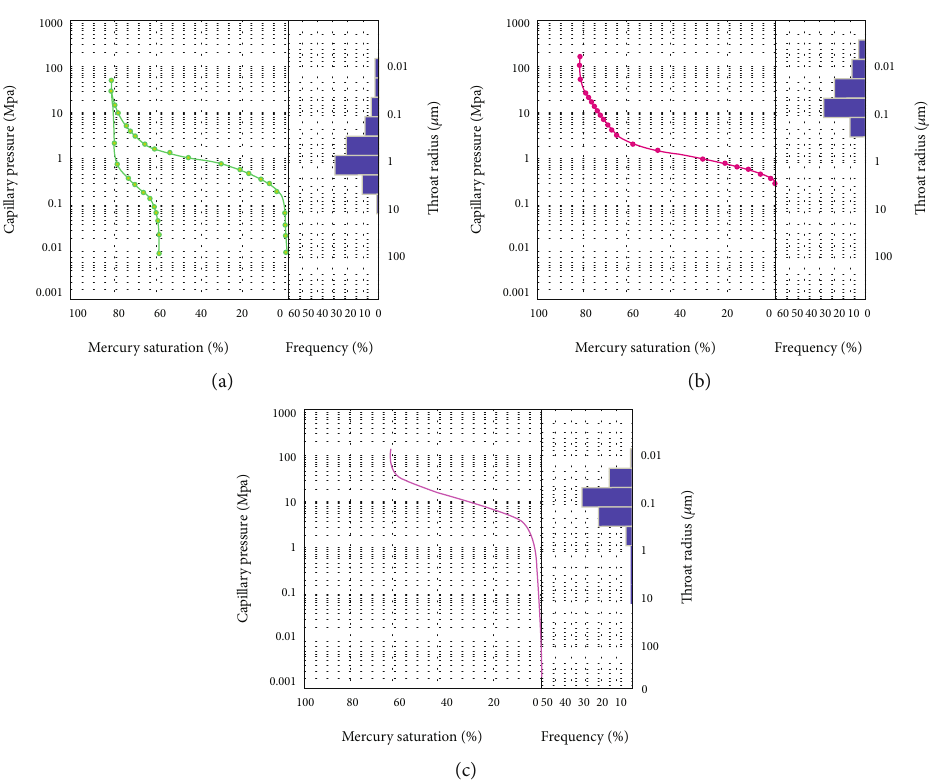
Figure 3: Pore structure of intercrystalline pore-type dolostone reservoir. ((a) MAMS pore structure, well S22, 3710.80 m; (b) MAFS pore structure, well Y1117, 4040.50m; (c). MEFS pore structure, well Y1112,